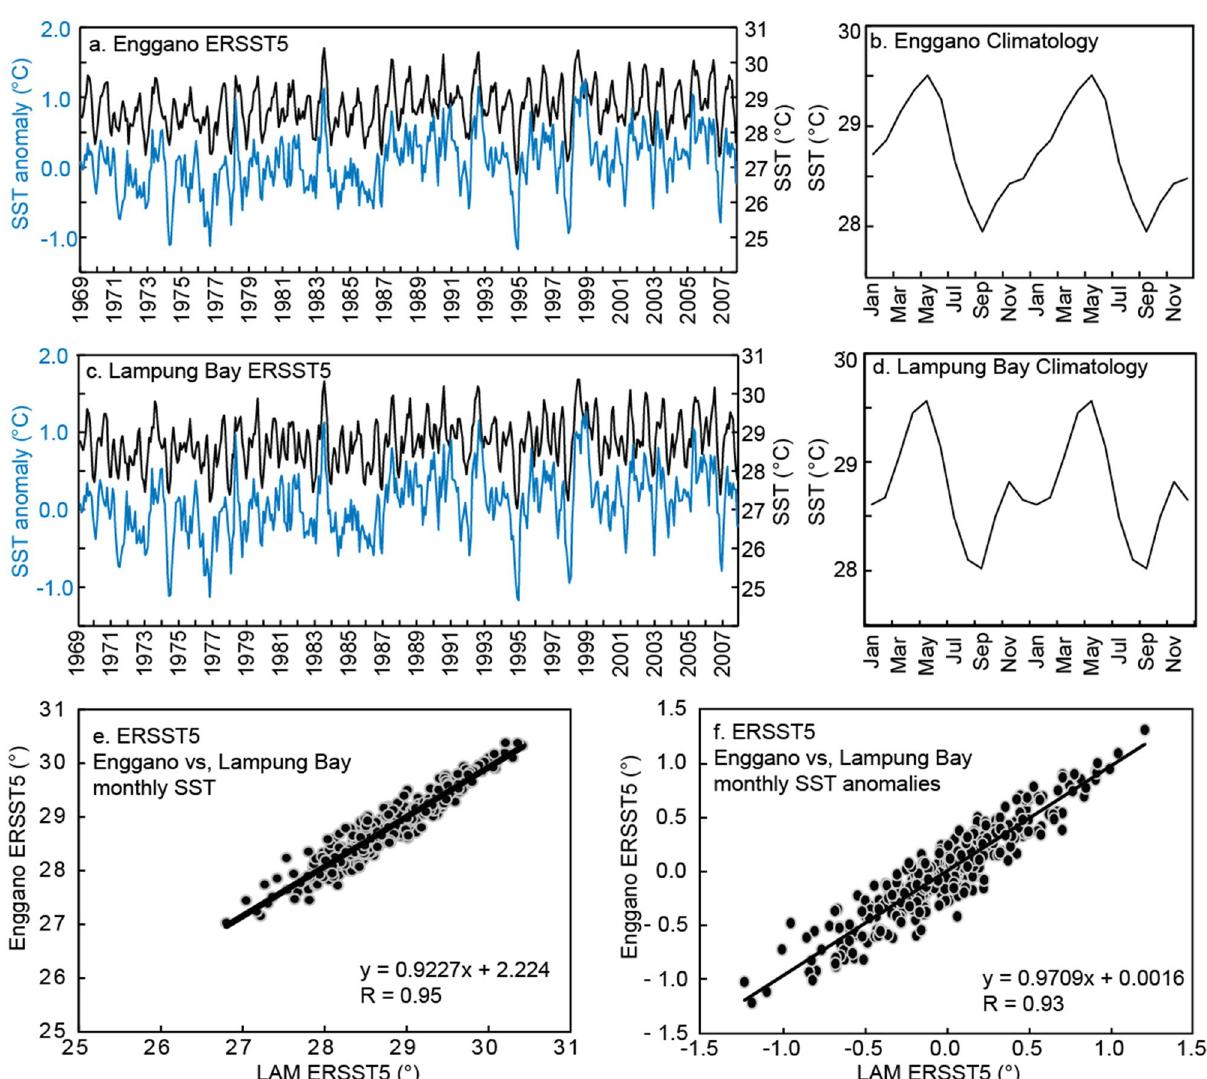
Figure 2. Sea surface temperature variability at Enggano Island and Lampung Bay. ( a–d ) (left) Monthly SST (black lines), its anomaly (blue lines) and (right) its climatology. ( e ) Linear regression of monthly SST from Enggano Island versus SST from Lampung Bay. ( f ) Same as ( e ) but for monthly anomalies. SST data is from ERSSTv5 49 from the grid boxes including the coral sites, and displayed over the period of Nov 1968–Sep 2007: ( a , b ) Enggano Island (102.125 E 5.375 S) and ( c , d ) Lampung bay, Sunda strait (105.578 E 5.749